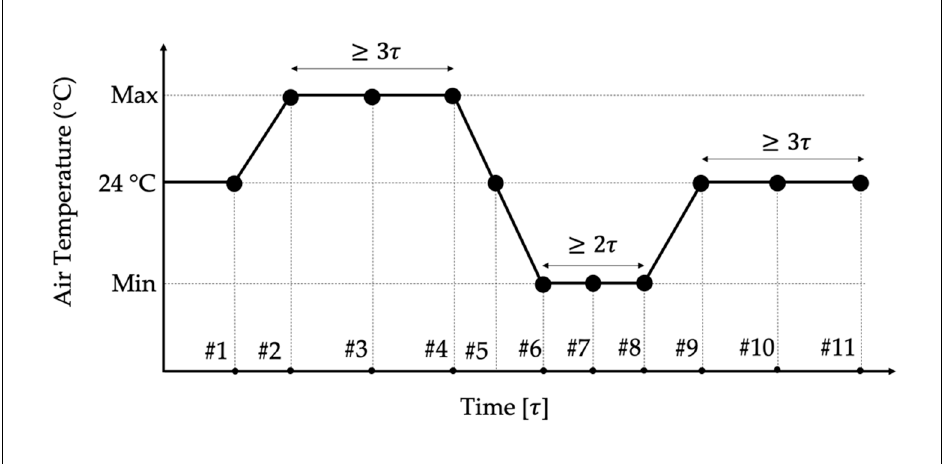
Figure 3. Setup used to test the LPVTs when external electrical fields are acting on them.